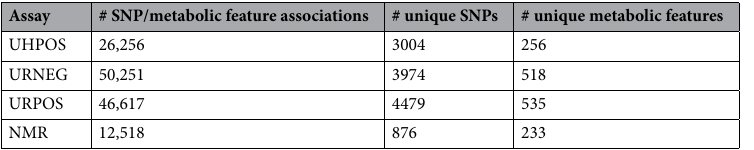
Table 3. Metabolic QTL mapping results. Numbers of associations between metabolic features and SNPs found using q-value cut-off 0.01, resulting in a number of unique metabolic features and a number of unique SNPs for each metabolomic assay.